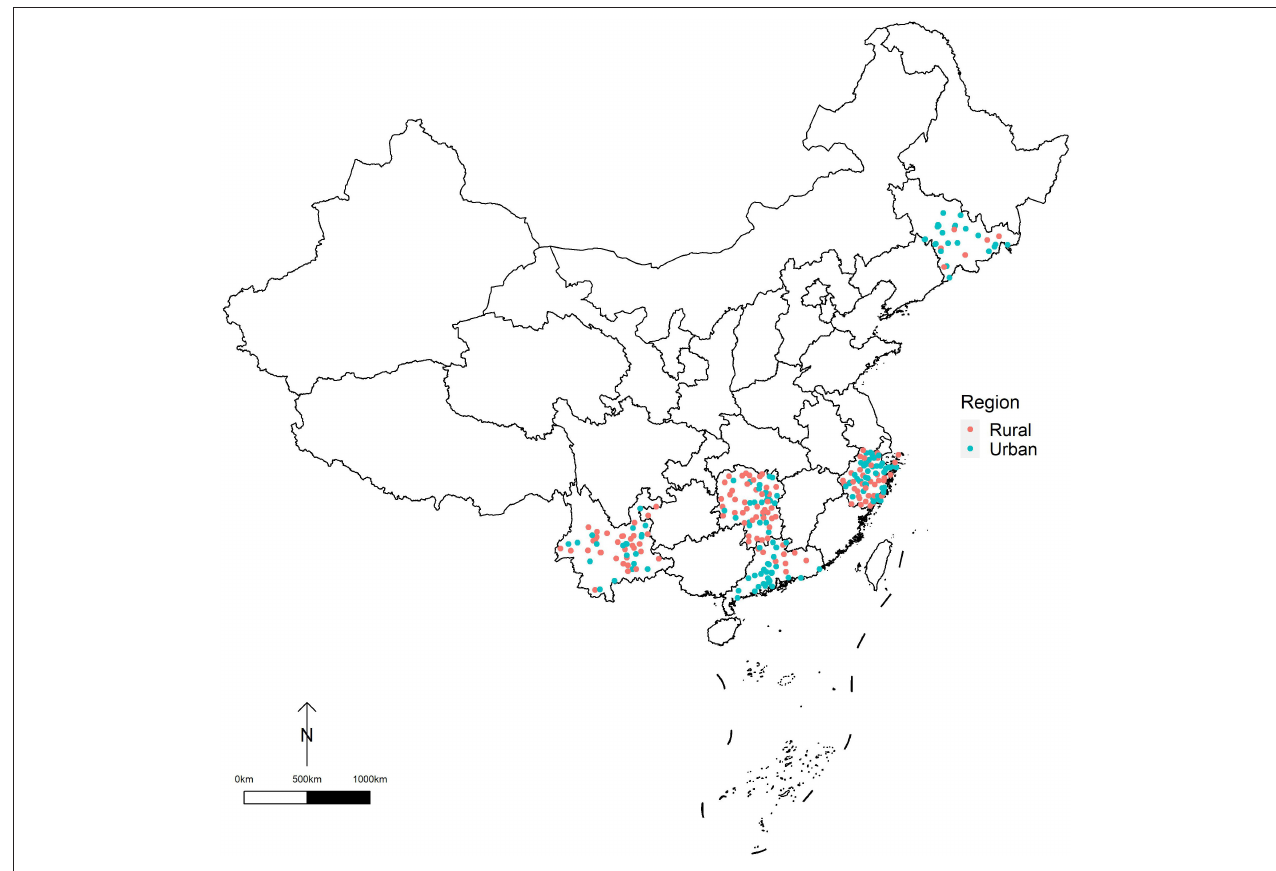
FIGURE 1 | The geographical distribution of 285 study locations in